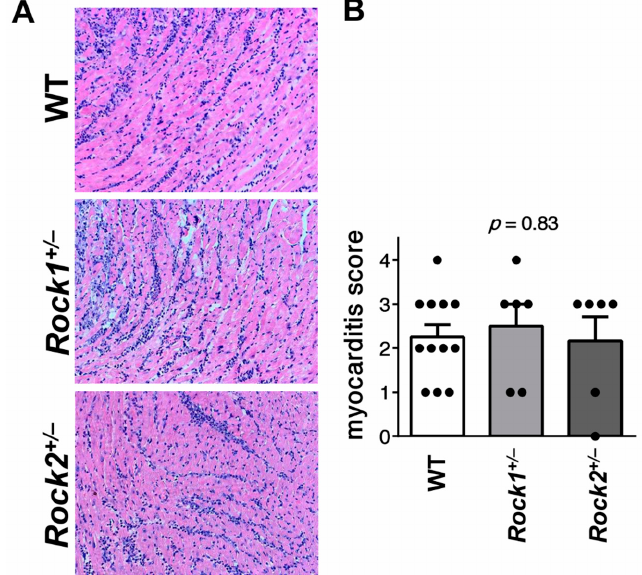
Figure 1. Unaffected myocarditis in Rock1 +/ − and Rock2 +/ − mice Panel ( A ) shows representative hematoxylin and eosin staining of heart tissue sections obtained from wild-type (n = 12), Rock1 +/ − (n = 6) and Rock2 +/ − (n = 6) mice at day 21 of experimental autoimmune myocarditis (EAM). Magnification x100. Quantification of myocarditis severity by using a semiquantitative 0-4 scale is shown in ( B ). Each dot represents data for one mouse and bars present mean value ± SEM. p -value was calculated with the Kruskal–Wallis test.